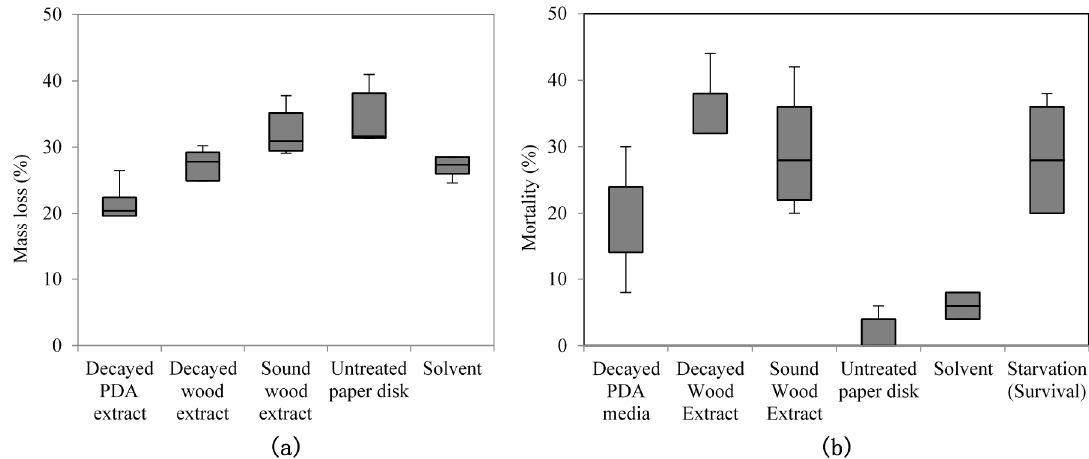
Figure 1. Box plot of ( a ) mass loss and ( b ) mortality in termites caused by feeding on paper disk treated with extracts from decayed wood or potato dextrose agar (PDA) (Kruskal-Wallis H test, p <